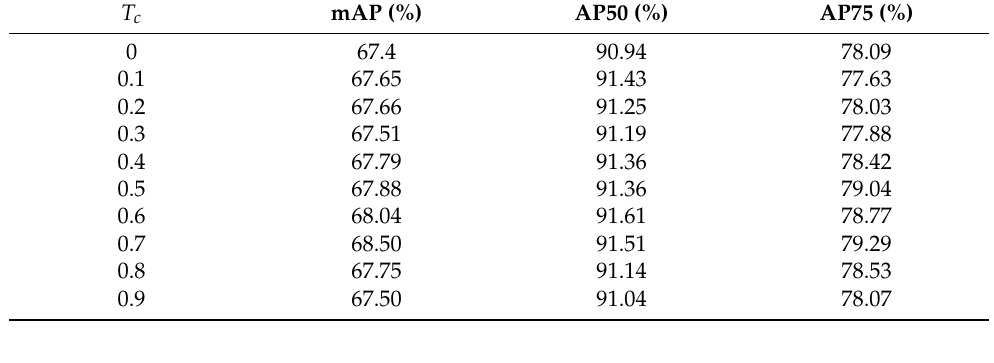
Figure 11. AP75 of different models under different random crop sizes. Table 4. Test results of different Table 4. Test results of different T c .